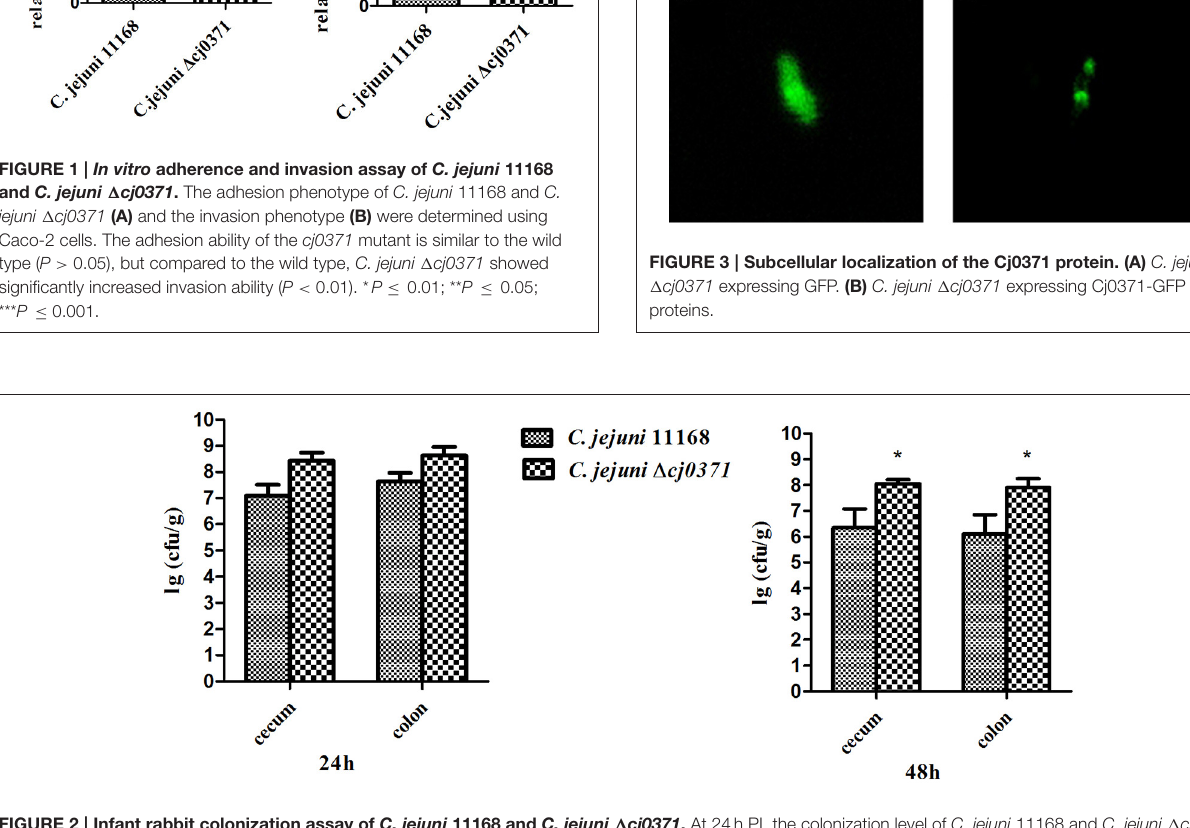
FIGURE 2 | Infant rabbit colonization assay of C. jejuni 11168 and C. jejuni 1 cj0371 . At 24h PI, the colonization level of C. jejuni 11168 and C. jejuni 1 cj0371 has no significant differences ( P > 0.05 ). However, 48h PI, the colonization level of C. jejuni 1 cj0371 is significantly high than C. jejuni 11168 ( P < 0.05 ). * P ≤ 0.01 ; ** P ≤ 0.05 ; *** P ≤ 0.001